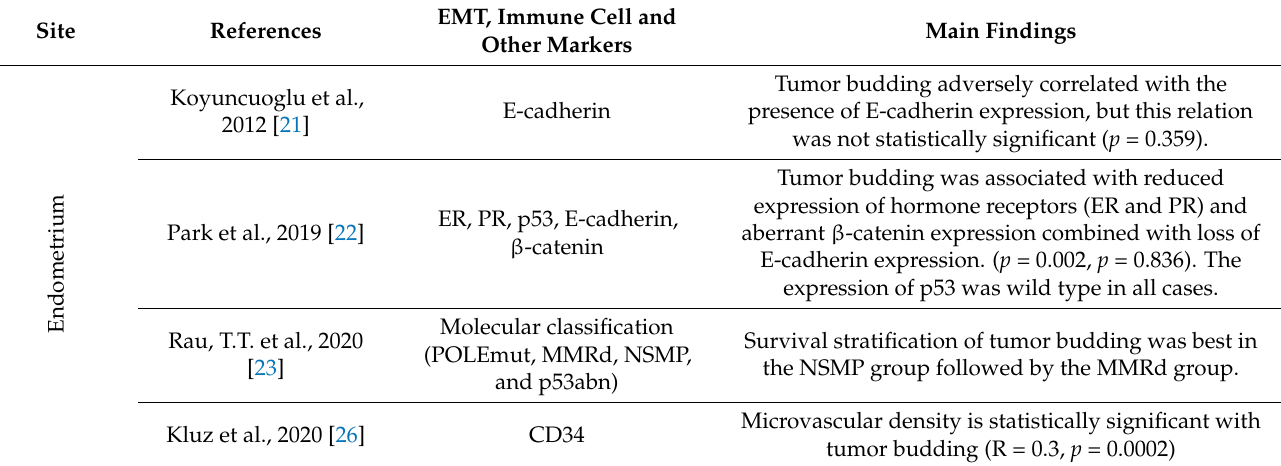
Table 3. Summary of tumor budding’s relationship with molecular